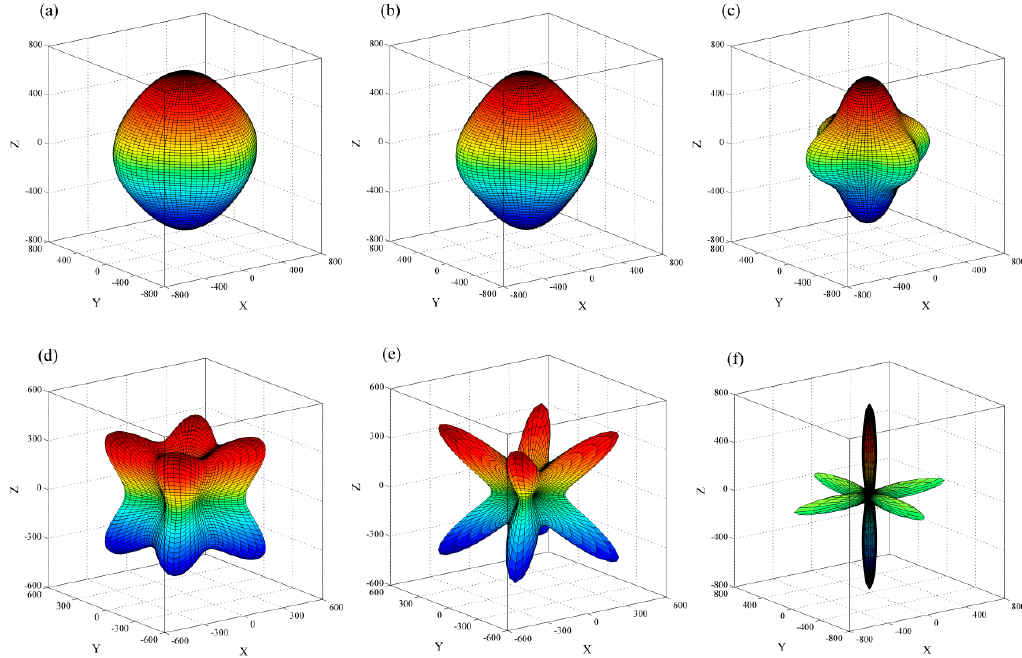
Figure 7. Directional dependence of the Young’s modulus of BC 12 ( a ); CC 12 ( b ); PC 12 ( c ); SC 12 ( d ); ClC 12 ( e ); and KC 12 ( f ).